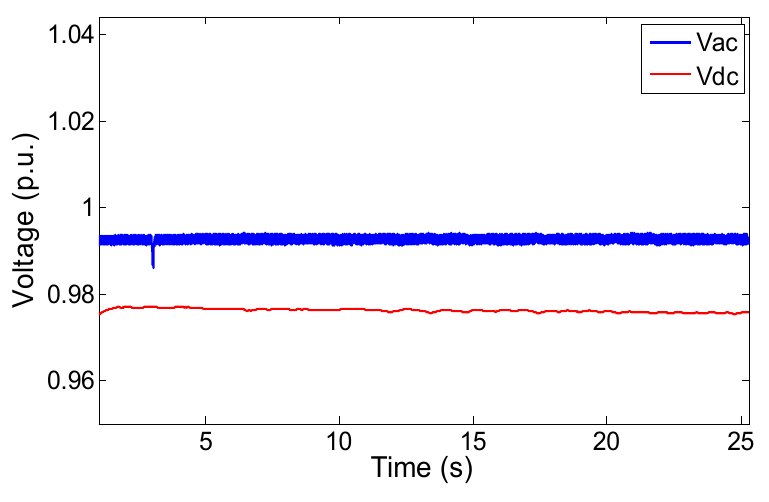
Figure 18. AC and DC voltages in the first case.